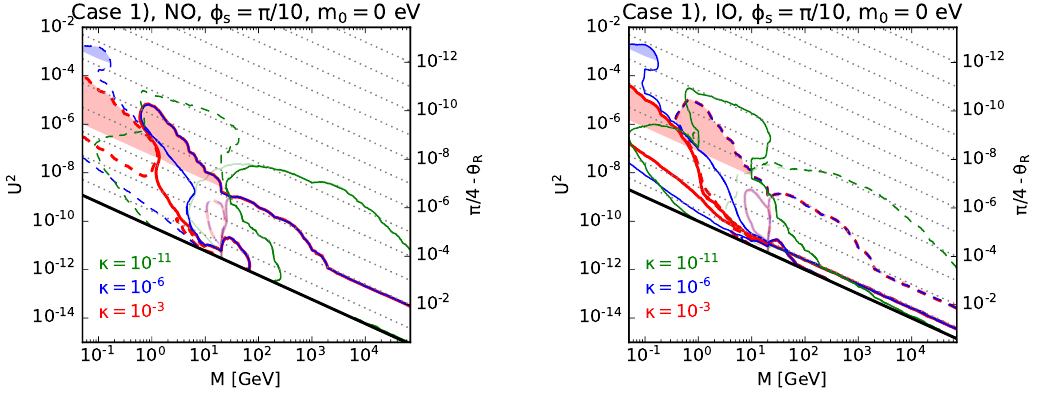
Figure 9 . Case 1) Range of total mixing angle U 2 consistent with leptogenesis for the Majorana mass varying between 50 MeV and 70 TeV. The splitting κ is chosen among the three values . Light κ ∈ { 10 − 3 , 10 − 6 , 10 − 11 } . The angle θ R can be read off. The value of φ s is fixed to φ s = π 10 neutrino masses follow strong NO (left plot) and strong IO (right plot), respectively. The contours corresponding to positive (negative) BAU are shown in continuous (dashed) lines. Note that these refer to vanishing initial conditions except for the lines shown in fainter colours. The sign of the BAU can be changed either by changing the signs of the couplings y or the sign of the splitting κ f or by replacing the parameter s by n − s for s being odd, compare the CP-violating combinations in eqs. (6.17) and (6.18). For masses larger than M ∼ 10 GeV, we see that the lines for κ = 10 − 6 and κ = 10 − 3 coincide. This can be verified in figure 4, where Y B becomes independent of the splitting κ for κ & 10 − 6 . In contrast, for κ = 10 − 11 both Y B and the allowed total mixing angle U 2 are generically larger for these larger masses. The blue and red shaded areas show the regions in which the condition in eq. (3.69) and alike is not satisfied. The black lines indicate the seesaw line, defined in eq.